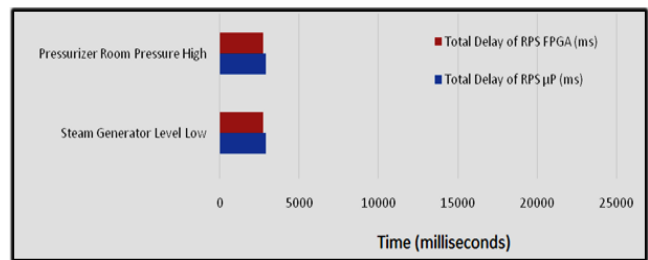
Fig. 23. Comparison of total delay between FPGA and microprocessor based RPS